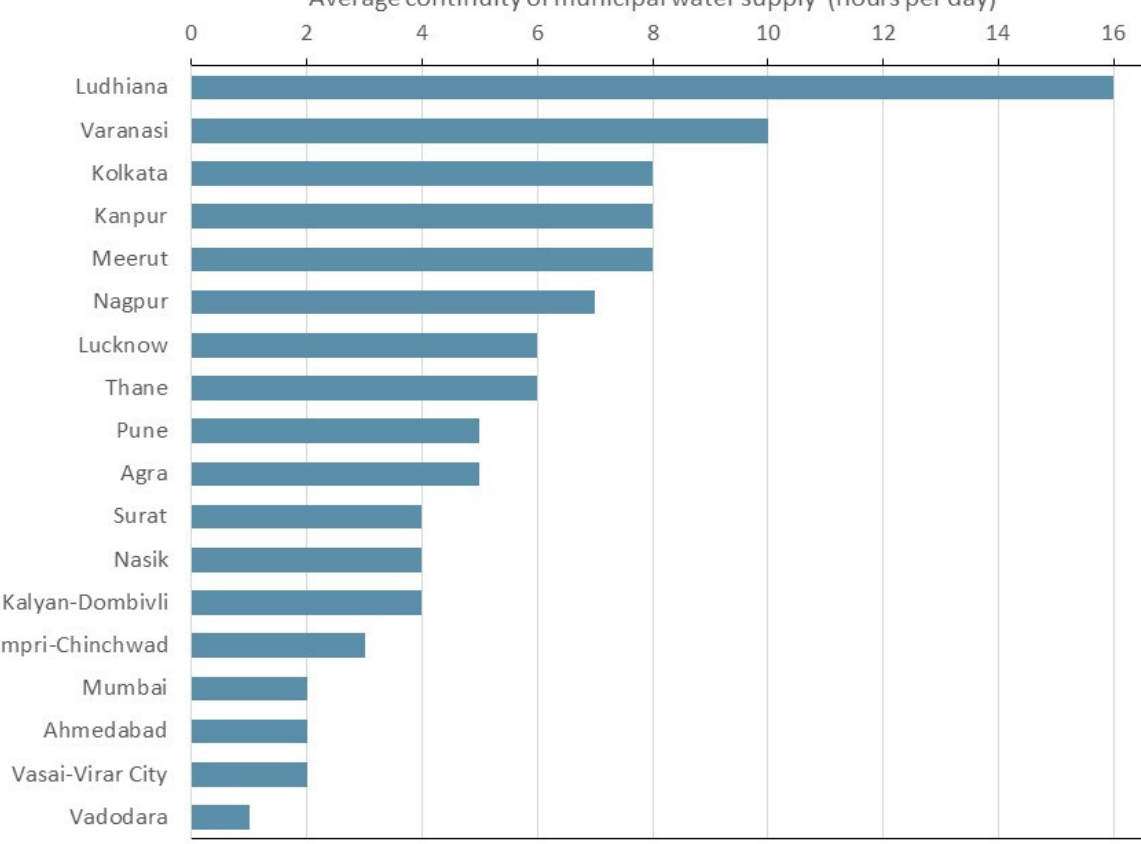
Figure 9. Municipal water supply in South Asian cities is typically intermittent and is not continuously available to consumers.